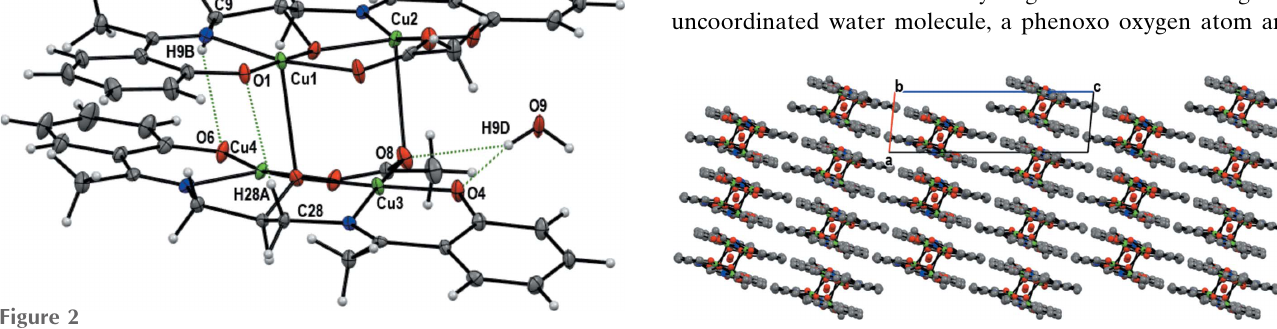
Figure 3 Sheets parallel to the ac